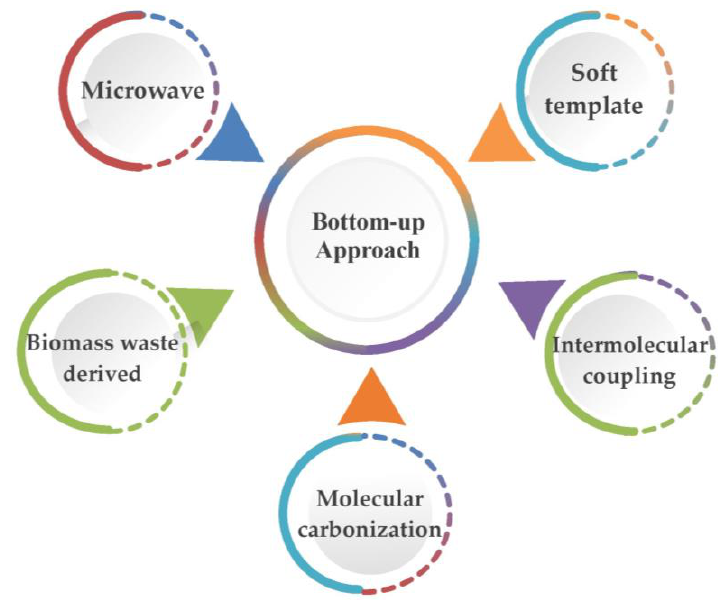
Figure 10. Schematic depicting the different techniques of the bottom-up approach used for the preparation of GQDs. The top-down approach involves breaking down the carbon material structures. In microwave (MW)-assisted synthesis, the frictional energy generated via molecular rotation of polar solvents by MW energy is utilized. In order to reduce the longer reaction time of hydrothermal methods, the fusion of microwaves with a hydrothermal approach, termed microwave-assisted hydrothermal (MAH) synthesis, helps in making the synthesis process swifter and more efficient. Waste/biowaste-derived sustainable synthesis of GQDs entails the carbonization of waste materials and biomass residues. Intermolecular coupling protocol has the advantage of generating GQDs with controlled size and shape. Molecular carbonization is a facile environmentally friendly technique where organic molecules are dehydrated and further carbonized.